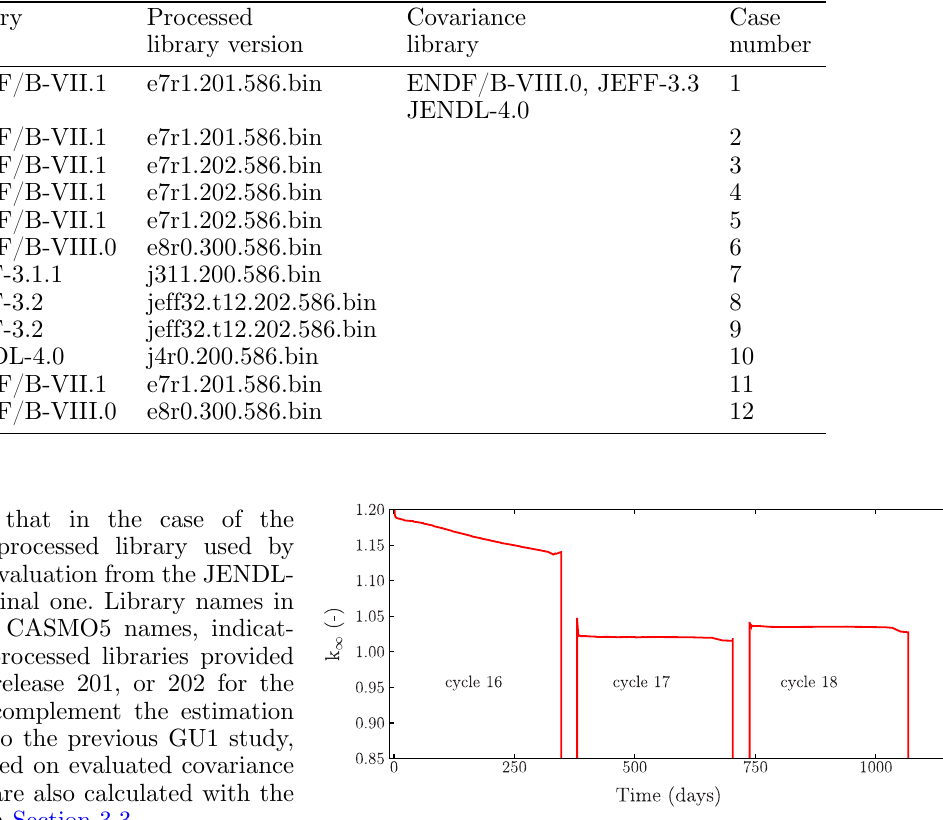
Fig. 3. Calculated k ∞ values during the three cycles of interest for the CASMO5 assembly